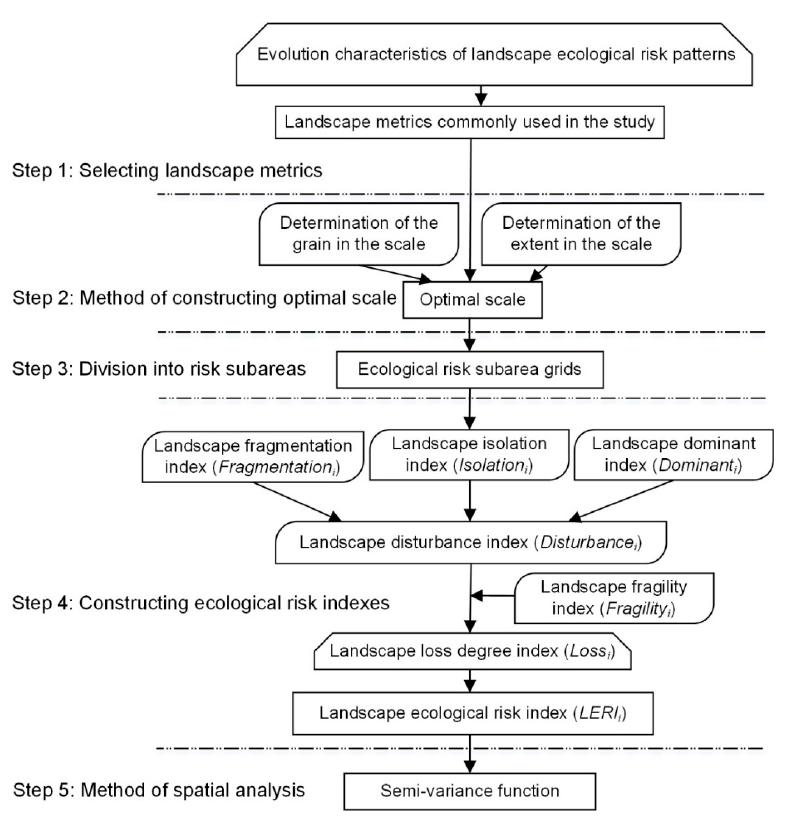
Figure 2. Framework of the methodology used for the landscape ecological risk assessment.